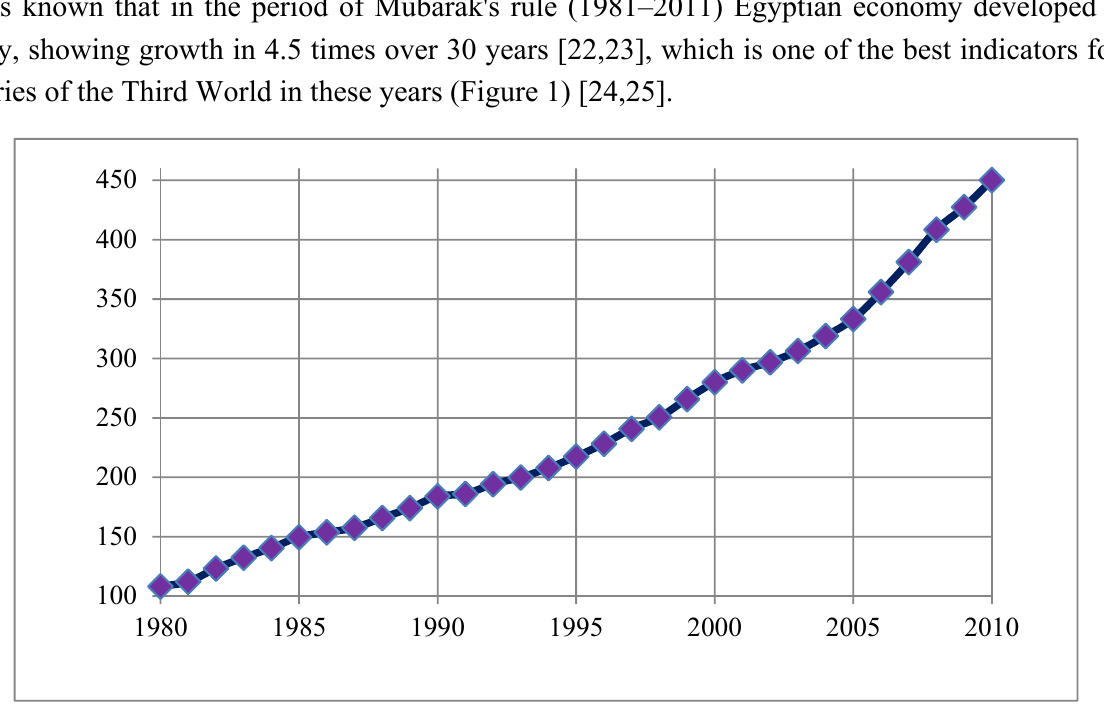
Figure 1. Dynamics of GDP (PPP) 2 in Egypt in 1980–2010, in billion dollars